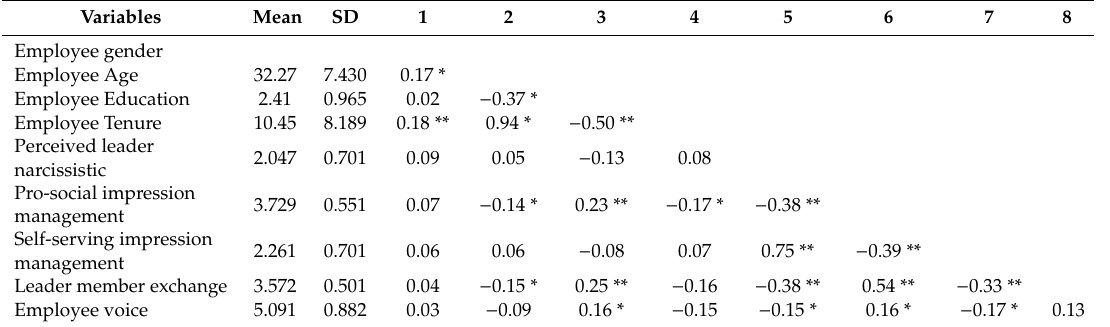
Table 1. Means, Standard Deviations, and Correlations.